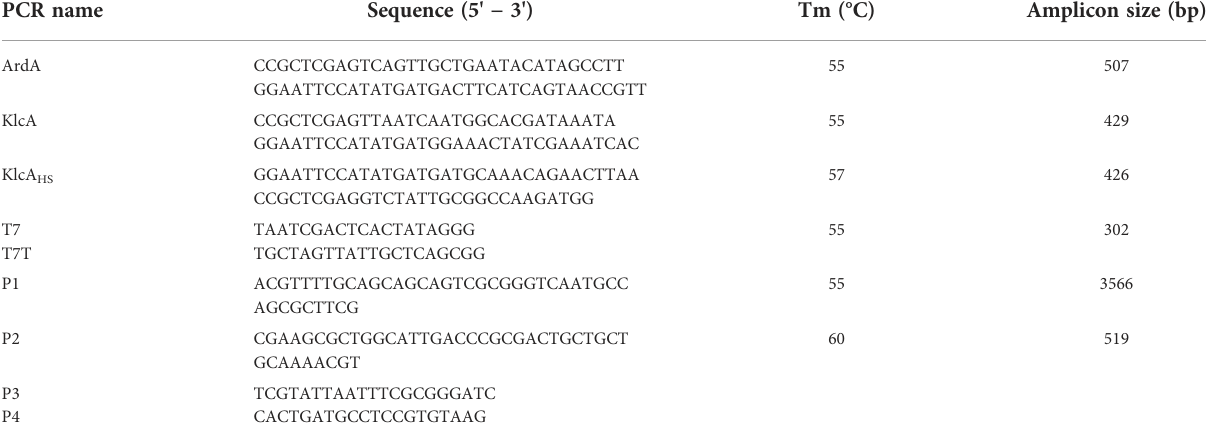
TABLE 1 The underlined part of the primer is the introduced restriction endonuclease recognition